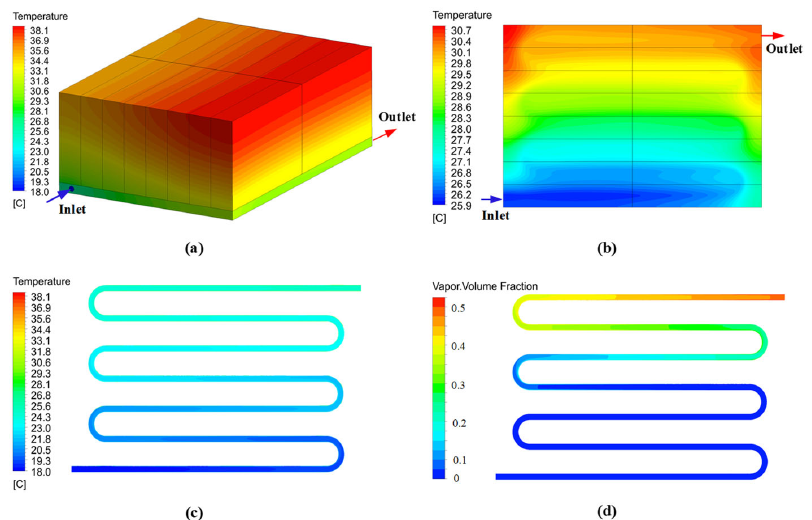
Figure 6. ( a ) temperature field of the module; ( b ) temperature field of cold plate; ( c ) temperature of R1233zd; ( d ) vapor volume fraction in channel.